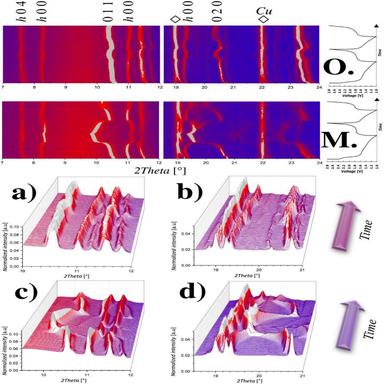
Operando XRD patterns at C/10 with corresponding charge-discharge curves and hkl indices (above), with magnified regions of orthorhombic (a-b) and monoclinic (c-d) FeNb11O29.